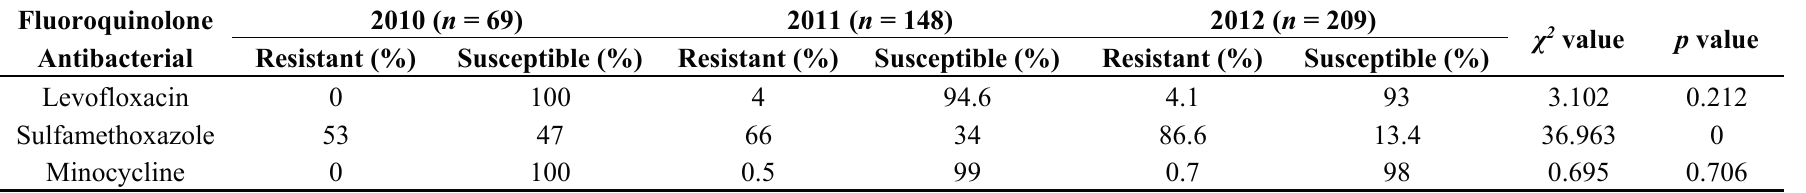
Table 2. Resistance of Stenotrophomonas maltophilia to three fluoroquinolone antibacterial drugs from 2010 to 2012. Fluoroquinolone Antibacterial Levofloxacin